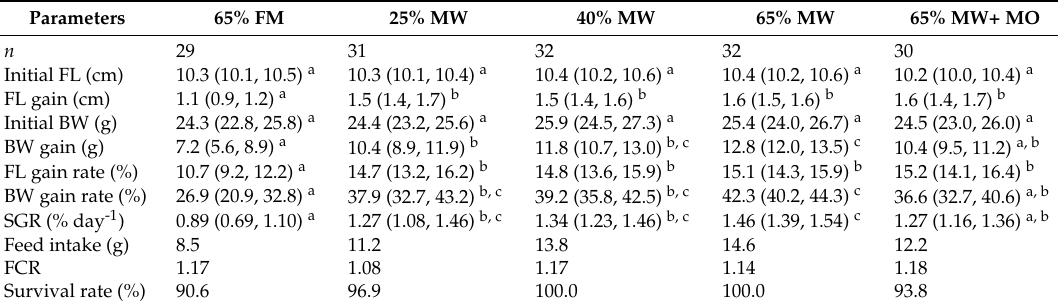
Figure 1. Growth performance of red seabream fed diets with a partial or complete replacement of FM with DMW-1 for a period of 4 weeks. Fork length gain ( a ) and body weight gain ( b ) at 4 weeks in the feeding trial. Values are means with their standard error represented by vertical bars [ n = 29 in 65% FM, 31 in 25% MW, 32 in 40% MW, 32 in 65% MW, and 30 in 65% MW and the oil fraction of mealworm larvae (65% MW + MO)]. Different letters (a, b, c) indicate statistically significant differences according to the Steel–Dwass multiple comparison tests as a post hoc test after a Kruskal–Wallis test ( p < 0.05). Table 5. Initial fork length and body weight, fork length and body weight gain, SGR, feed intake, FCR, and survival rate of red seabream fed diets with a partial or complete replacement of FM with DMW-1 for a period of 4